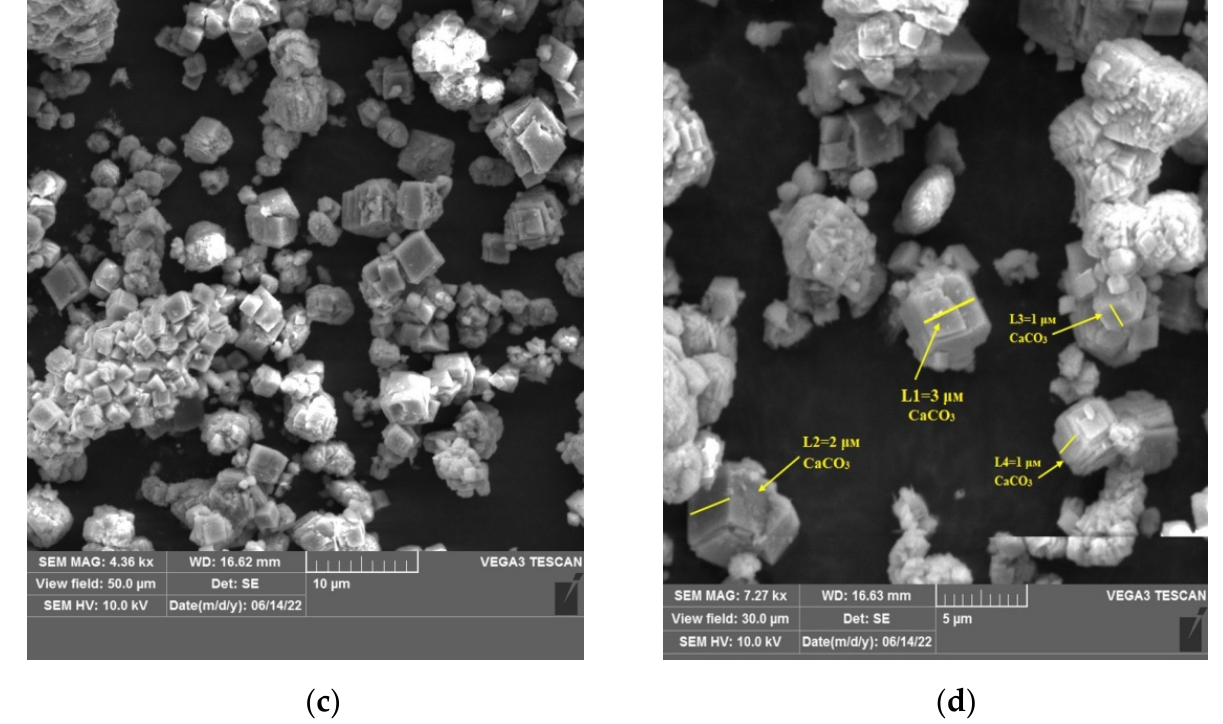
Figure 4. SEM micrograph of ( a , b )—watered phosphogypsum, ( c , d )—calcium carbonate obtained in the course of the conversion.